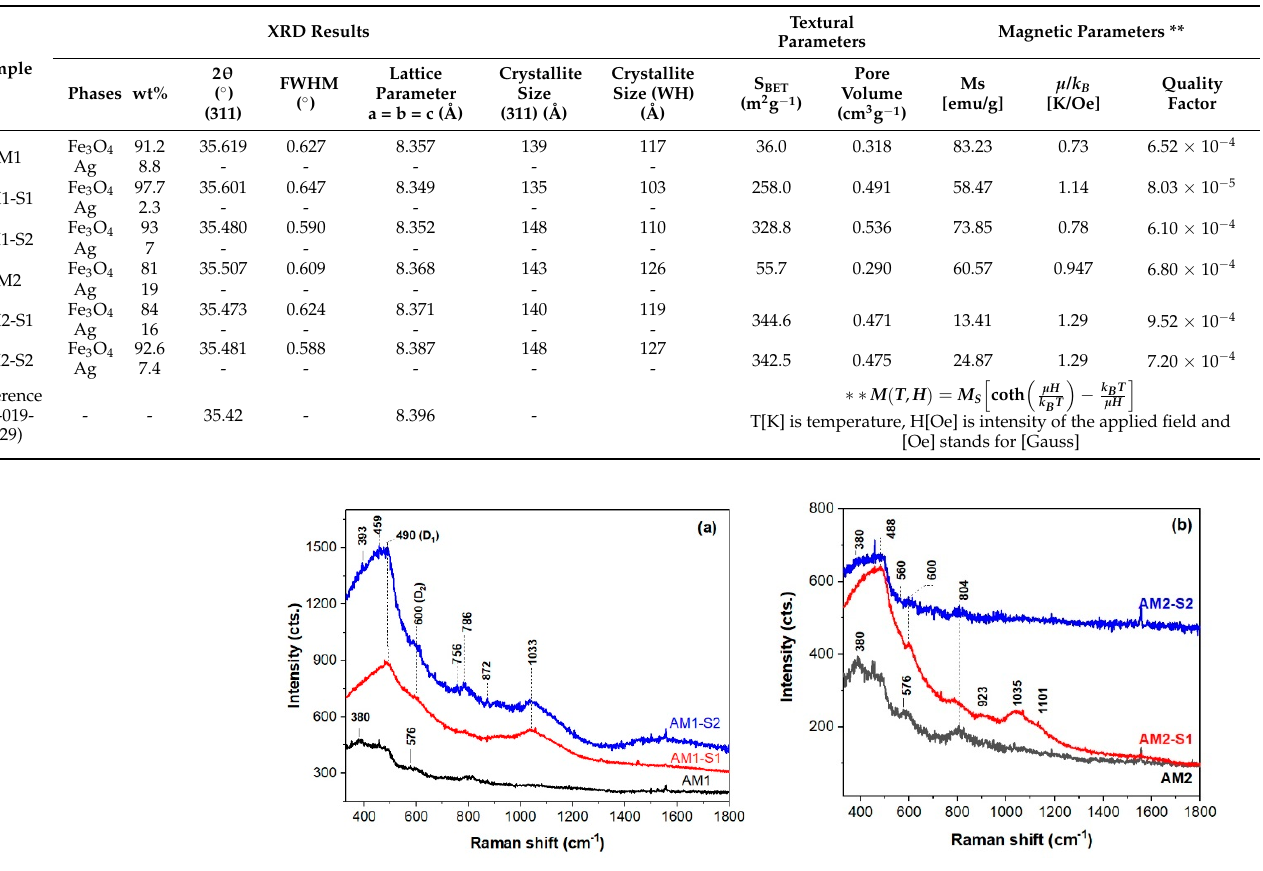
Figure 3. UV–Raman spectra of the ( a ) AM1(-/S1/S2) and ( b ) AM2(-/S1/S2) samples